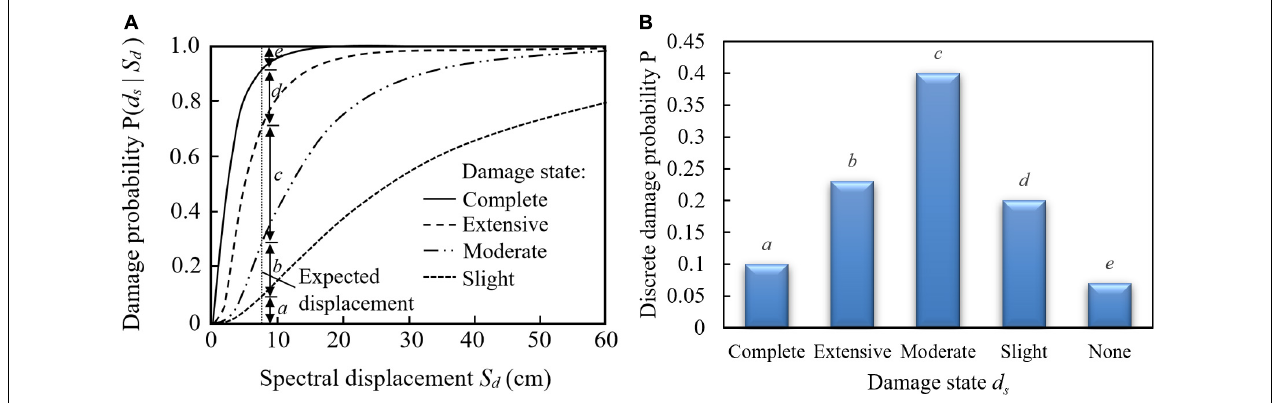
FIGURE 4 | Fragility curves of five damage states (FEMA, 2003). (A) Fragility curve of a building; (B) discrete damage